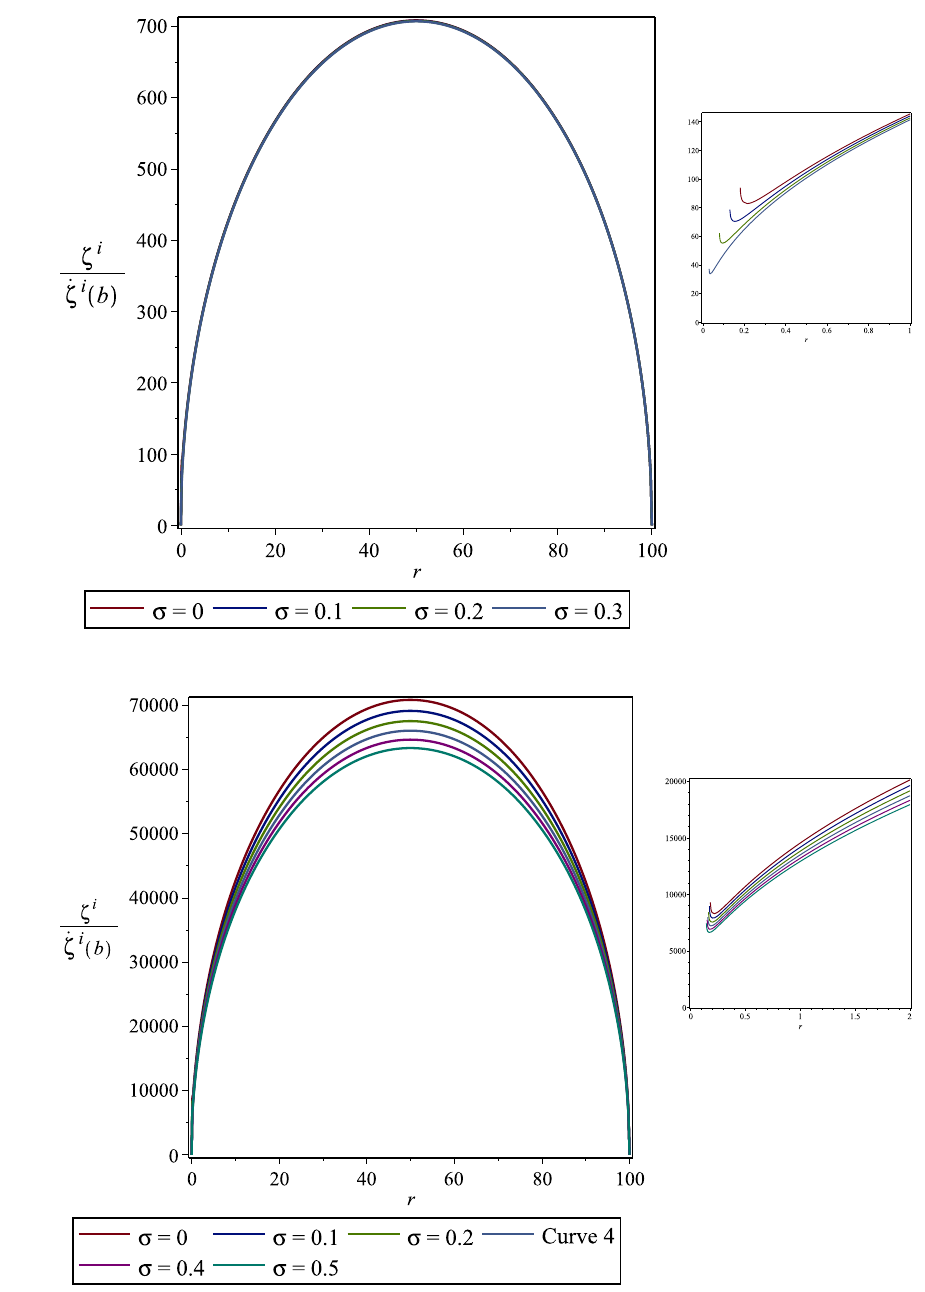
Fig. 9 Angular components of geodesic deviation for Kiselev BH surrounded by radiation with IC2 for different values of the radiation parameter with M = 1, q = 0 . 6 and b = 100